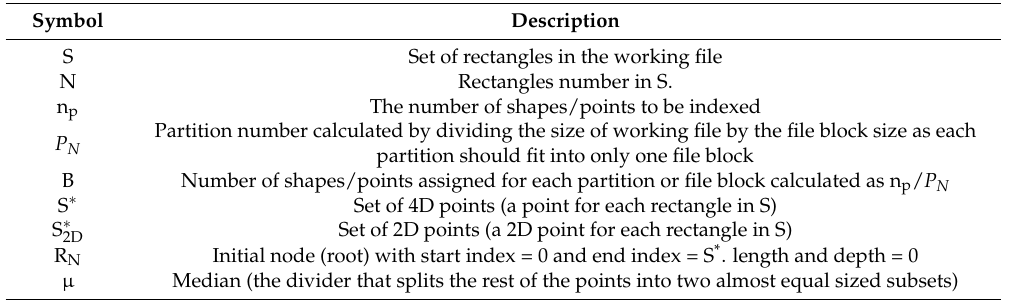
Table 2. Description of symbols that are used in the algorithms.